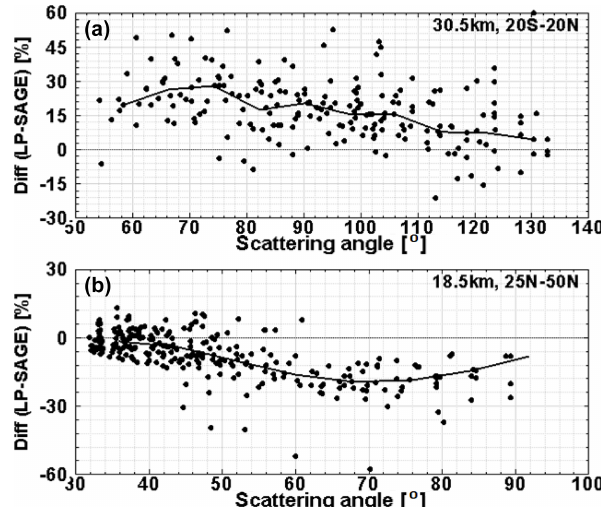
Figure 10. Relative differences in the aerosol extinction between LP and SAGE III/ISS along with the median difference (solid line) as a function of the LP scattering angle for an altitude of 30.5km in the 20 ◦ S–20 ◦ N (a) latitude bin and an altitude of 18.5km in 25–50 ◦ N latitude bin (b) during the period from June 2017 to May 2019. The differences in aerosol extinction values vary significantly with scattering angle between 50 and 100 ◦